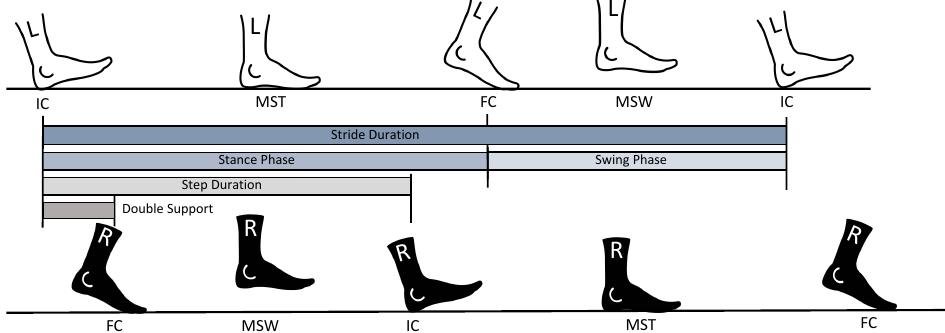
Figure 2. Schematic of the gait events initial contact (IC), final contact (FC), mid-swing (MSW), and mid-stance (MST) of a complete gait cycle and the corresponding gait